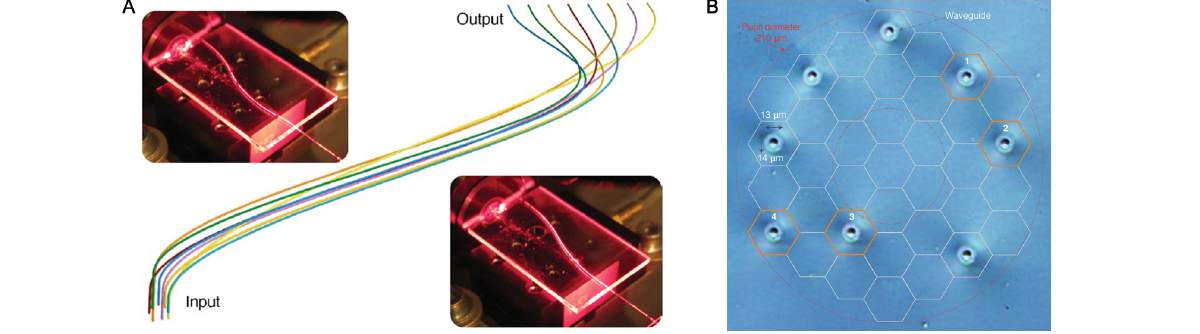
Figure 8: (A) 3D waveguide trajectory of the integrated pupil remapping chip for the DRAGONFLY instrument. The waveguides take a side step in order to avoid stray light at the output. The insets show red light being guided along the side step. (B) Microscope image of the chip’s input, which samples the telescope’s pupil. The 8 waveguides are placed on a hexagonal grid. With permission from [10]. Copyright 2012 Oxford University Press.